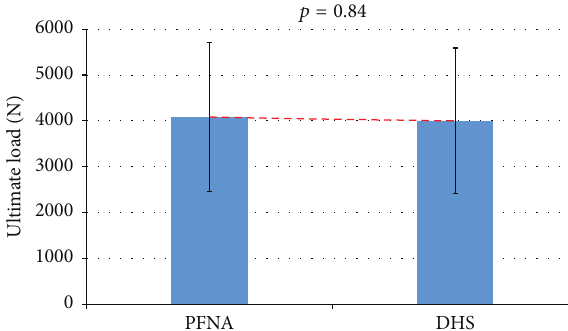
Figure 5: No difference in ultimate load between PFNA-II and DHS groups regardless of age ( 𝑝 = 0.57 , > 65 years; 𝑝 = 0.81 , < 65